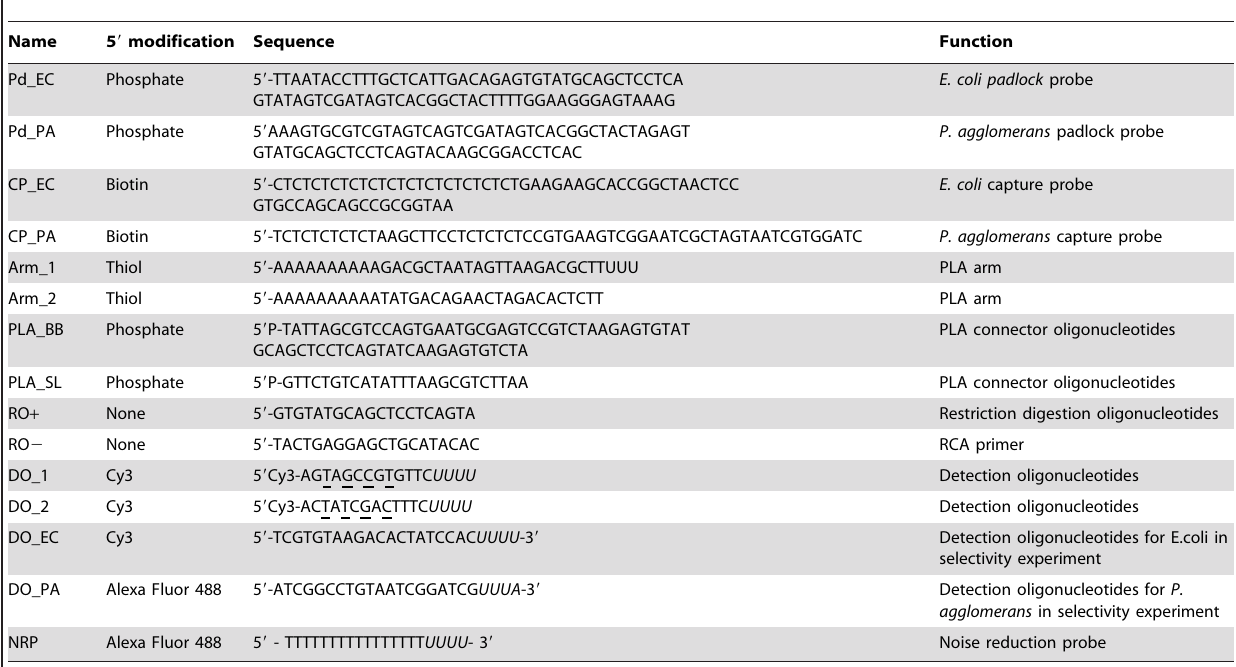
Table 1. Sequences of the oligonucleotides used in the study. Underlined nucleotides are locked nucleic acids [17].